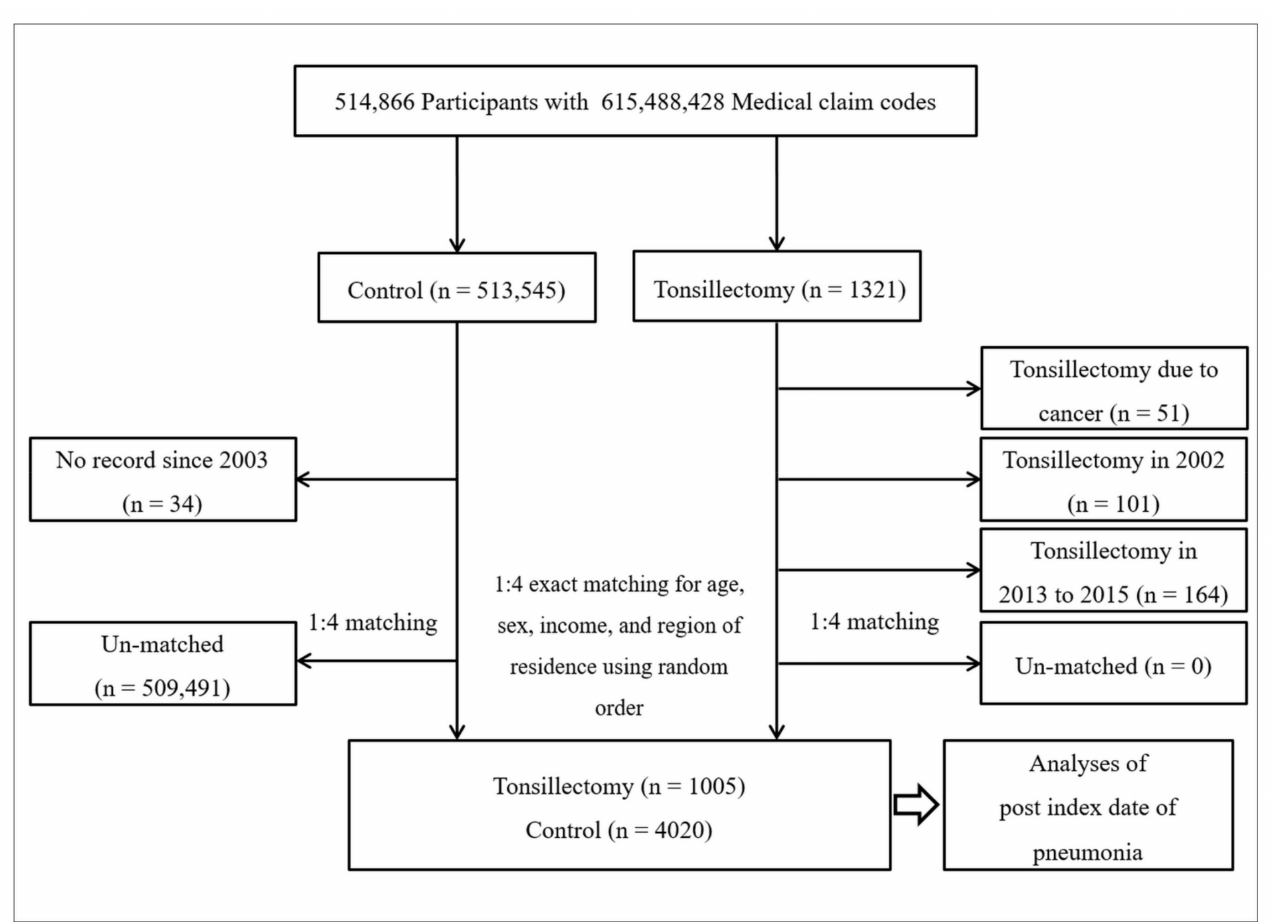
Figure 1. A schematic illustration of the participant selection process that was used in the present study. Of a total of 514,866 participants, 1005 tonsillectomy participants were matched with 4020 control participants for age, sex, income, region of residence, and pre-index date pneumonia for one